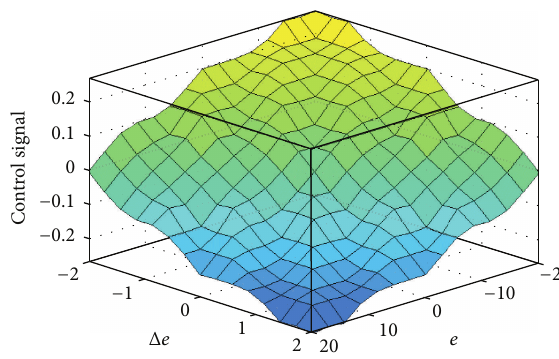
Figure 11: Surface viewer for